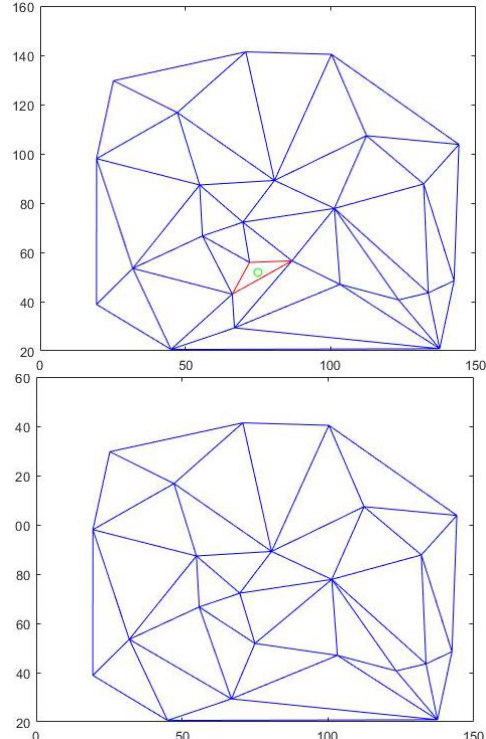
Figure 2: An example of a small (redundant) triangle removal: the triangle in red (top) is smaller than the predefined threshold, and thus is removed, where its vertices’ centroid is defined as a new point in the new DT process (bottom).